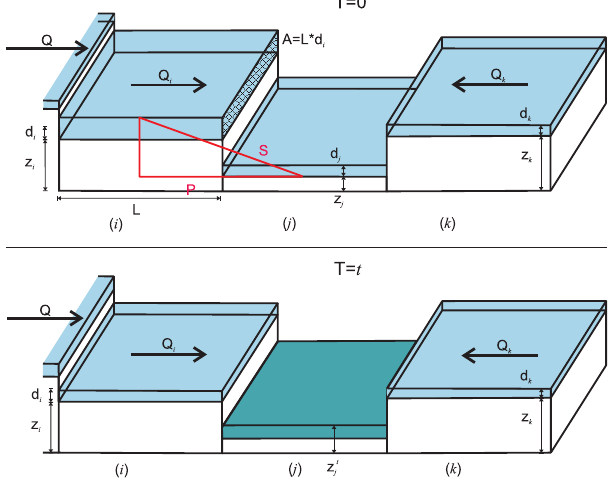
Fig. 2. Two-dimensional schematic of model processes including a sink cell ( j) . (Top) state of model at time t = 0, a layer of MAR- simulated runoff (blue) covers each cell. (Bottom) state of model at time t = t (one standard time step); the sink cell ( j) now has a lake surface (teal), given by Eq. (7), and cells i and k contain a combination of runoff from contributing cells and that internally generated by